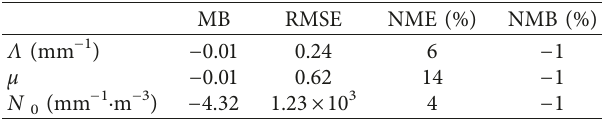
Figure 7: Retrieval results of the DSD parameters (second group): most of scatters are distributed in the line with the slope equal to Table 5: Statistical parameters of the second group for the results.